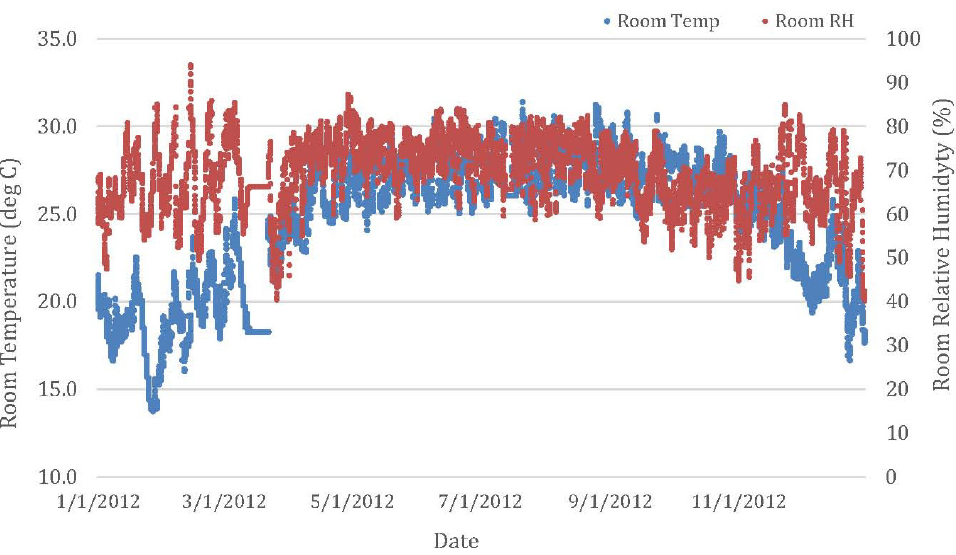
Figure 13. Shenzhen IBR indoor temperatures and relative humidity